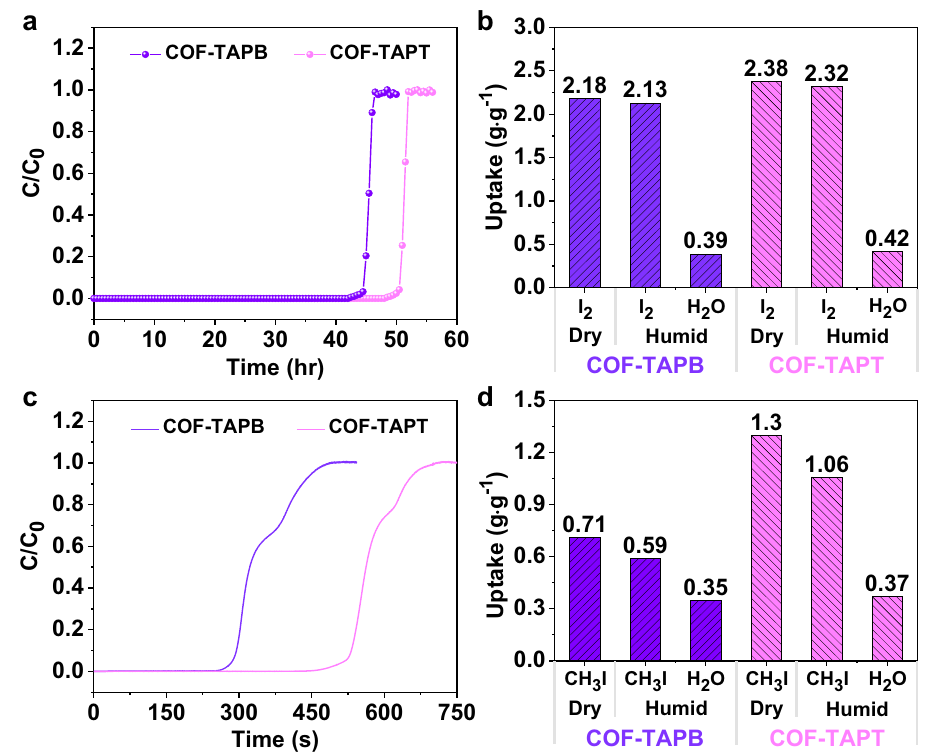
Fig. 4 Dynamic I 2 adsorption and CH 3 I adsorption performances. a I 2 breakthrough pro fi les of COF-TAPB and COF-TAPT at 25 °C. The concentration of I 2 in the carrier gas is 400 ppm. b Dynamic I 2 uptake values of COF-TAPB and COF-TAPT under dry and humid conditions. The water uptake under humidity is also presented. c CH 3 I breakthrough pro fi les of COF-TAPB and COF-TAPT at 25 °C. The concentration of CH 3 I in the carrier gas is 200,000 ppm. d Dynamic CH 3 I uptake values of COF-TAPB and COF-TAPT under dry and humid conditions. The water uptake under humidity is also presented.